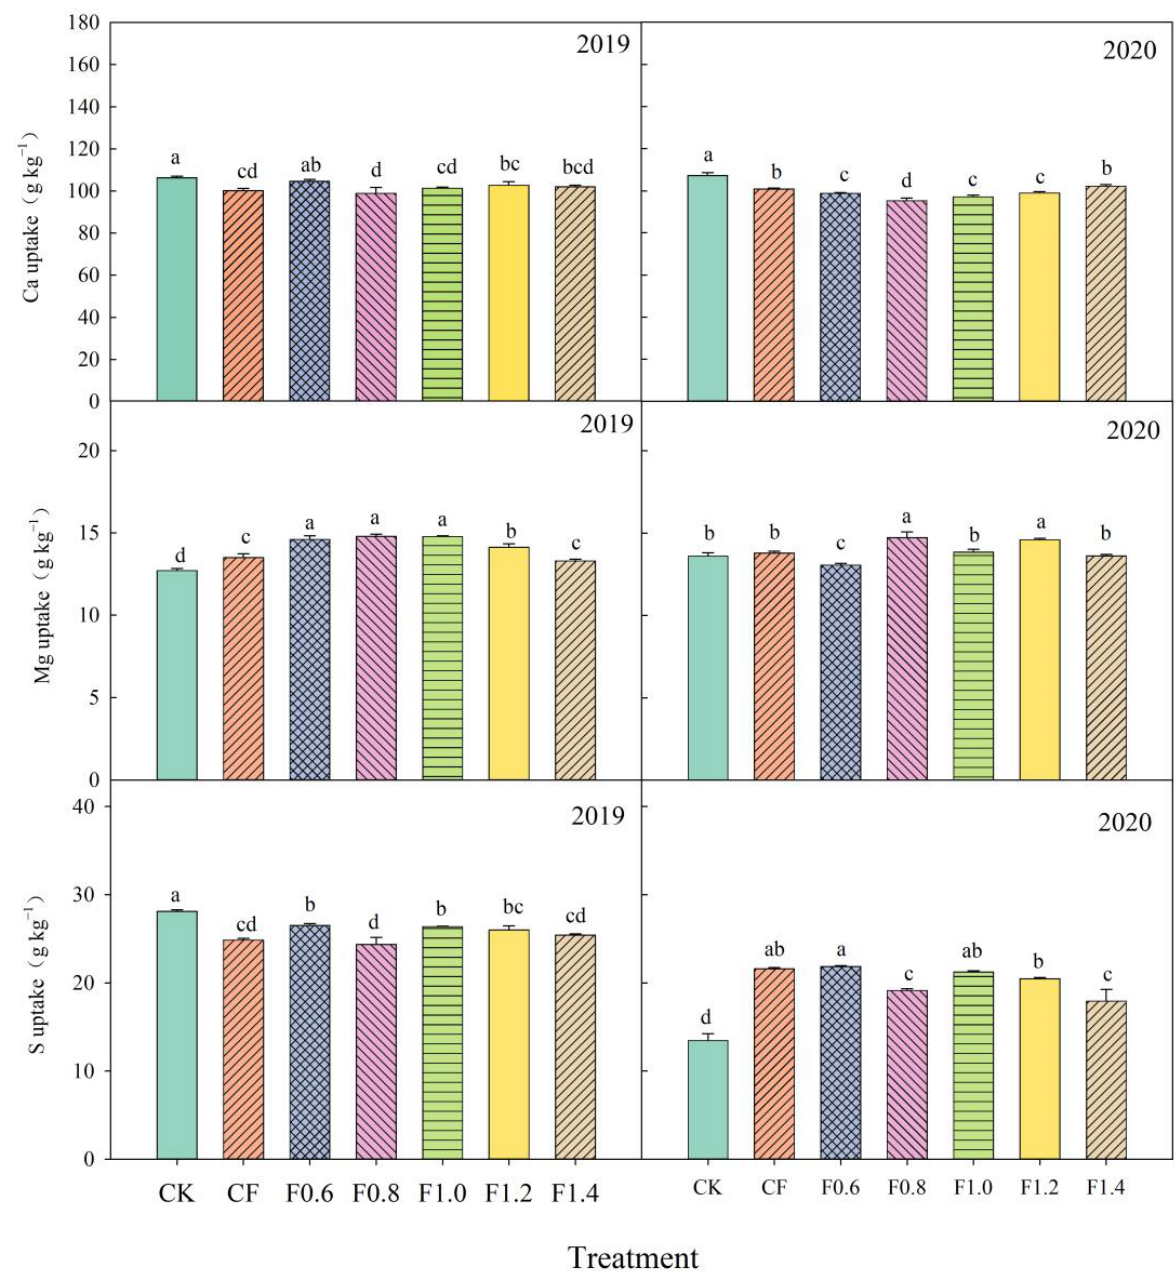
Figure 7. Change in Ca, Mg and S absorption in cotton under different fertilization patterns. Note: Values are means ± standard errors of three biological replicates. Bars with different letters in the same year are significantly different at p <